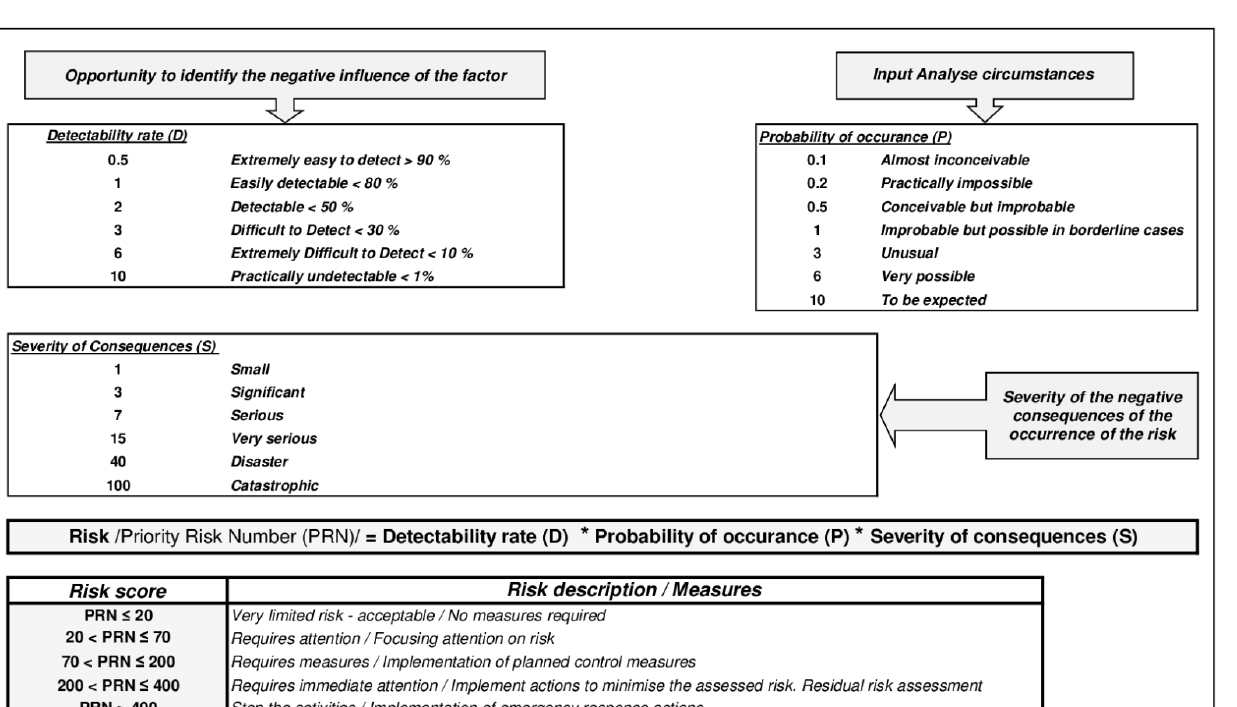
Figure 2. Determining the risk class (Source: authors).